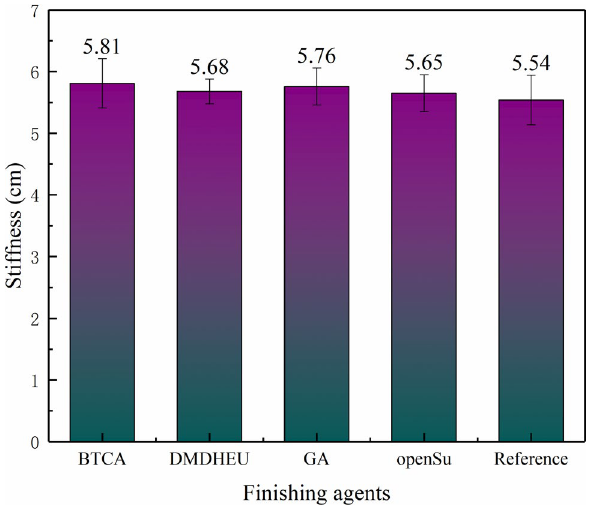
Figure 6. The stiffness of the finished fabrics with different finishing agents.